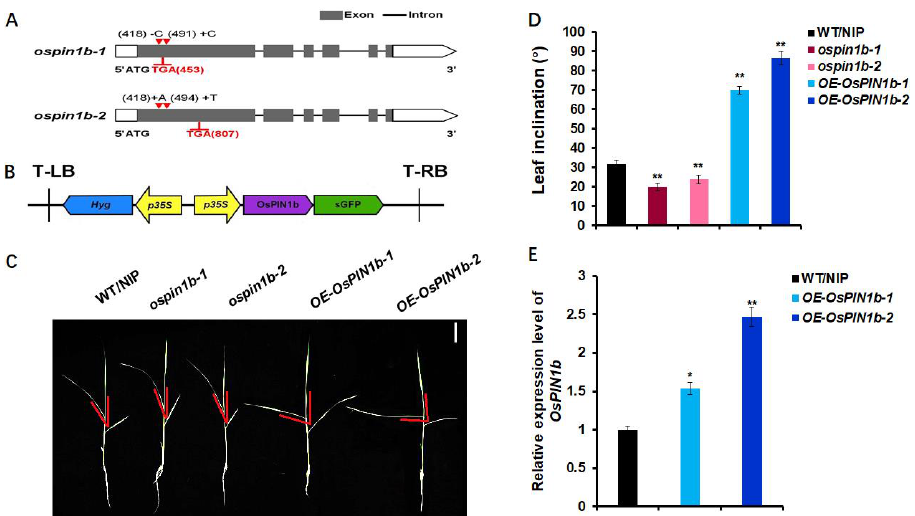
Figure 1. Characterization of ospin1b mutants and OsPIN1b overexpression lines. ( A ) Construction of two ospin1b mutants by CRISPR-Cas9. Gray boxes, black lines, and white boxes represent exons, introns, and untranslated region, respectively; + and ▼ indicates the insertion sites in ospin1b mutants, － and ▼ indicates the deletion site in ospin1b mutants. ATG and TGA presents start codon and stop codon. ( B ) Structure of OsPIN1b overexpression vector pCAMBIA1300-sGFP . ( C , D ) Phenotypes and statistics analysis of the leaf inclination in the second leaf of WT/NIP, ospin1b mutants, and OsPIN1b overexpression lines for 3-week-old seedling. The angle between the red lines represents the leaf inclination. The statistical data are mean ± SD (n = 3) and * indicates the significant difference among WT/NIP, ospin1b, and OE-OsPIN1b (** p < 0.01; Student’s t -test). Scale bar = 5 cm. ( E ) qRT-PCR analysis of OsPIN1b expression in WT/NIP and OsPIN1b overexpression lines. Three independent biological replicas were performed here. OsACTIN was used as an internal control. The data are mean ± SD (n = 3) and * indicates the significant differences between WT/NIP and OE-OsPIN1b (* p < 0.05, ** p < 0.01; Student’s t -test).